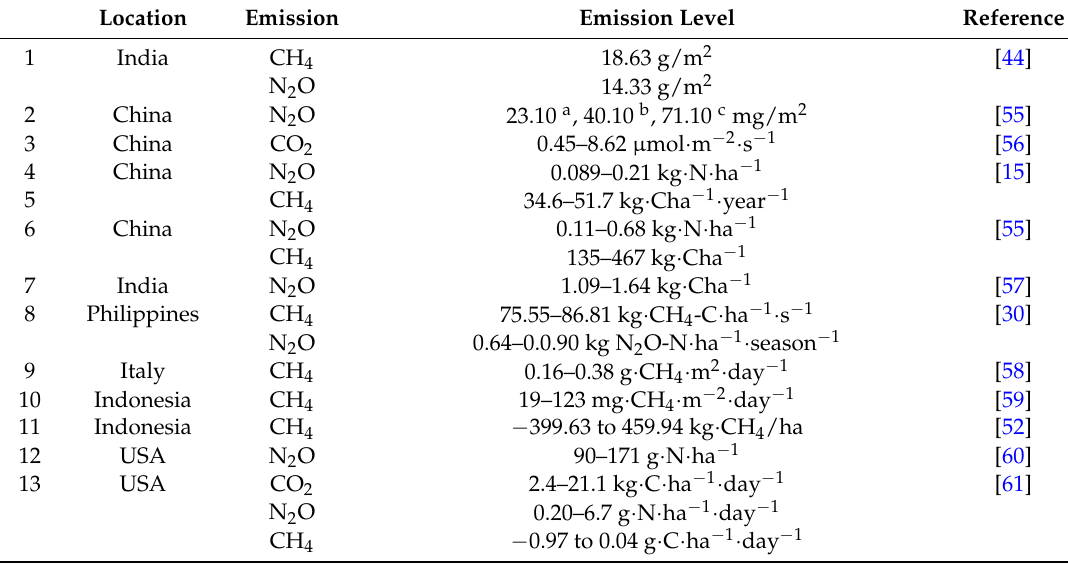
Table 2. Emission levels from various